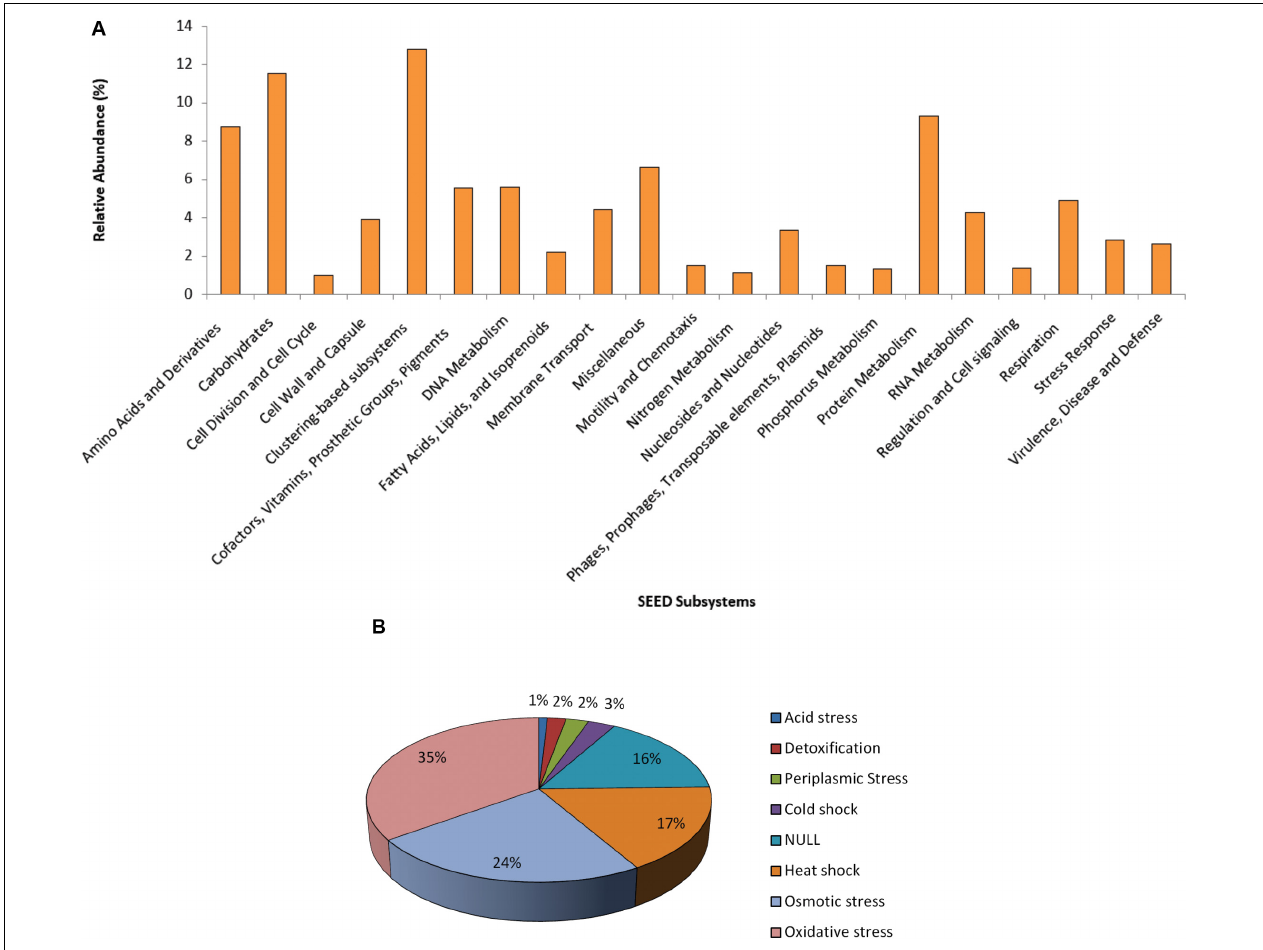
FIGURE 2 | Functional profile of the plasmidome. (A) The Puquio de Campo Naranja plasmidome sequences were compared with the SEED database for relative abundance of each of the major SEED subsystems by using a maximum E -value of ≤ 10 - 5 . SEED subsystems that were less abundant than 1% are not shown. (B) “Stress Response” subsystem level 2 classification of the SEED database. The Puquio de Campo Naranja plasmidome was compared with the SEED database for relative abundance of each category from “Stress Response” subsystem by using a maximum E -value of ≤ 10 - 5 . Relative abundance was calculated as the percentage of total matches with the database corresponding to each subsystem or